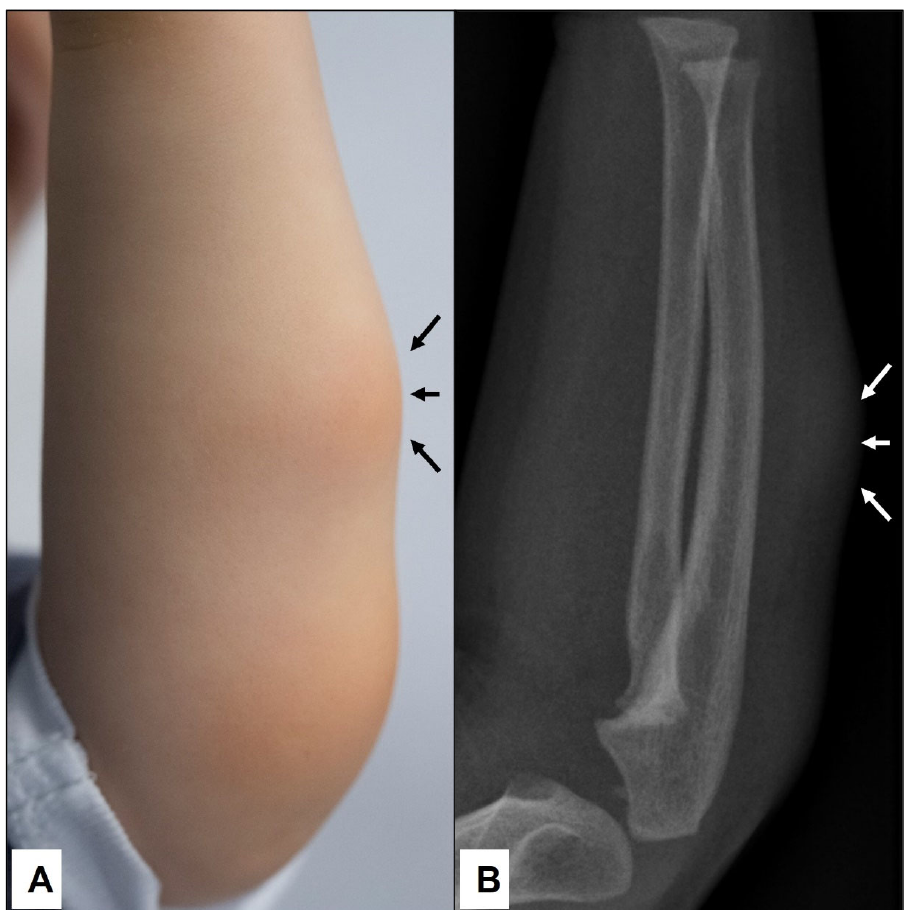
Figure 3. A 2 ‐ year ‐ old boy was presented by his parents due to the swelling on the left forearm, which persisted for the last 2 months ( A )—(black arrows). Because the subcutaneous lump was firm and immobile, an X ‐ ray was conducted to exclude bone abnormalities ( B ). Note the homogenous soft tissue expansion in the subcutaneous area (white arrows) but no osseous involvement.